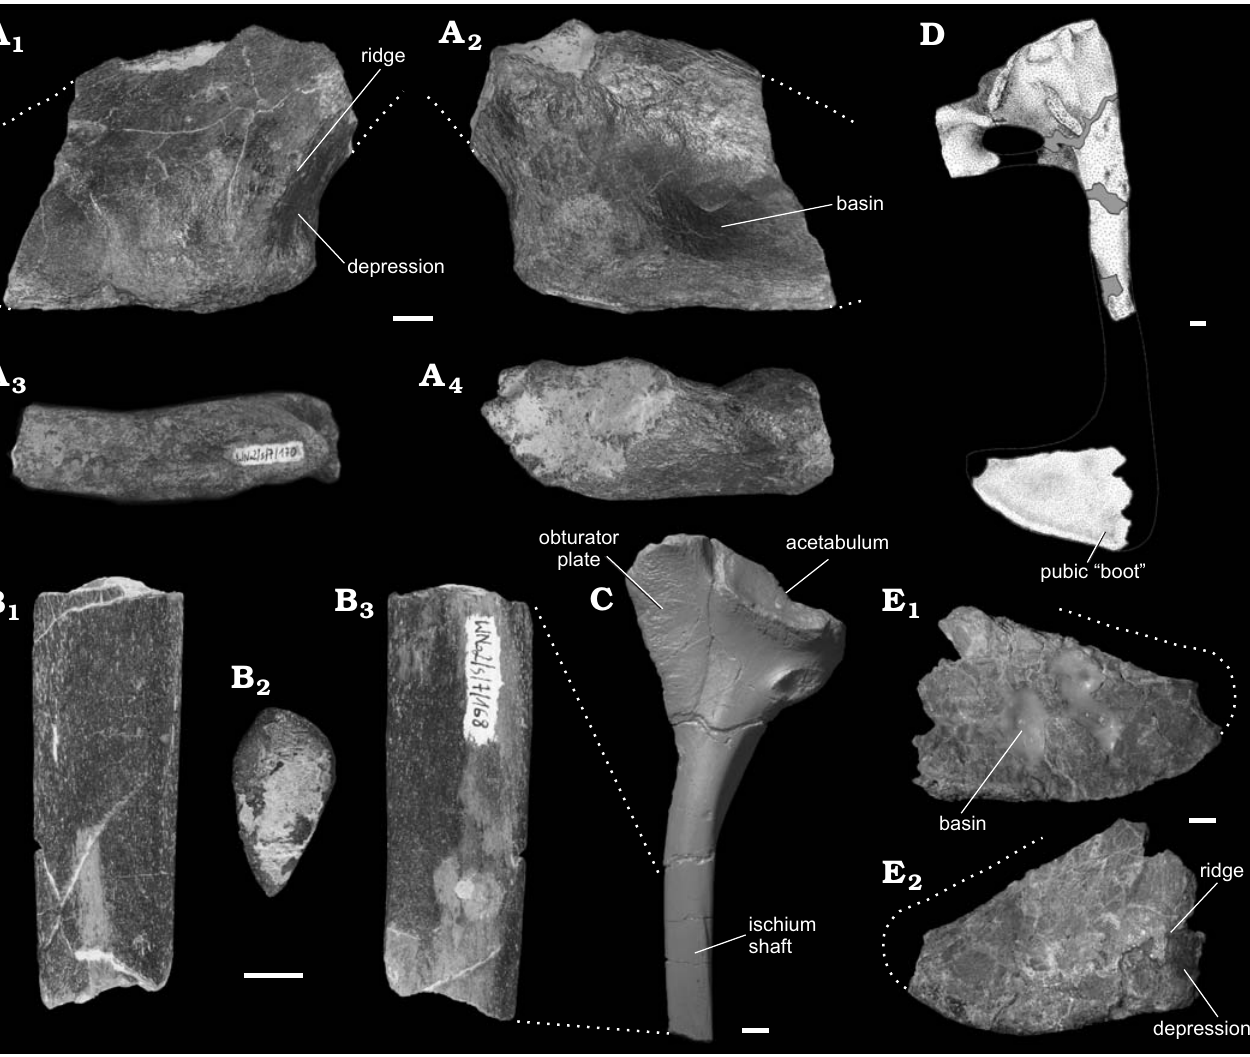
Fig. 4. Predatory archosaurs from Late Triassic of Poland, Smok sp., Marciszów near Zawiercie (A, B) and Smok wawelski Nied ź wiedzki, Sulej, and Dzik, 2012, Lipie Ś l ą skie clay-pit at Lisowice (C–E). A . Distal part of the right pubis, pubic “boot” (WNoZ/S/7/170), in lateral (A 1 ), medial (A 2 ), ventral (A 3 ), and dorsal (A 4 ) views. B . Middle part of the left ischium shaft (WNoZ/S/7/168), in lateral (B 1 ), dorsal (B 2 ), and medial (B 3 ) views. C . Left ischium (ZPAL V.33/302), in lateral view. D . Reconstruction of right pubis in lateral view; based on specimens ZPAL V.33/311A, B and ZPAL V.33/298 (from Nied ź wiedzki 2013). E . Distal part of the right pubis, pubic “boot” (ZPAL V.33/298), in medial (E 1 ) and lateral (E 2 ) views . Scale bars 10